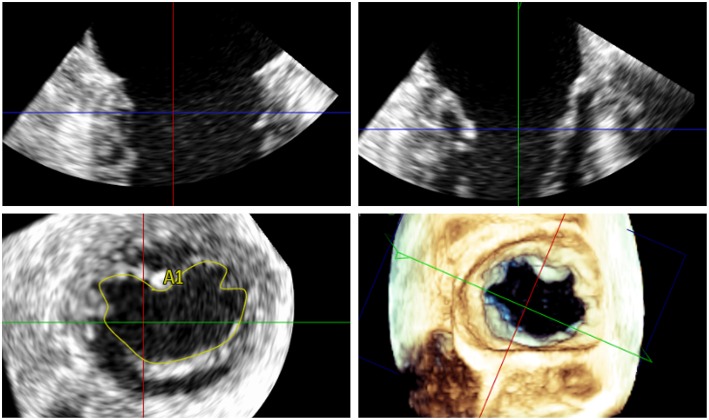
Measurement of the 3D mitral valve area (MVA) by transoesophageal echocardiography in a patient with severe MR; the MVA in this case was 5.48 cm2 indicating suitability for percutaneous mitral valve repair.